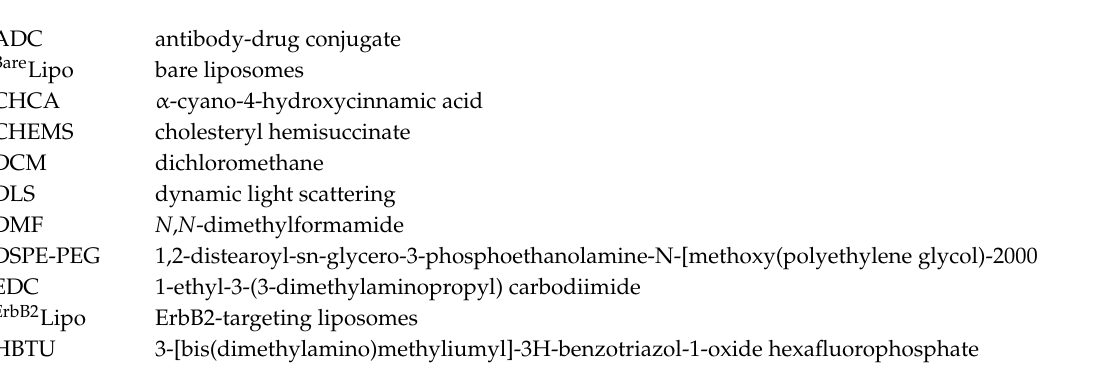
Table S1. Fmoc determination. Figure S1. Synthetic chemical structure of DSPE-PEG-ErbB2. Figure S2. Characterization of ErbB2 Lipo. (A) Size of ErbB2 Lipo under physiological condition (pH 7.4, 6.5 and 5.0, respectively) for 5 days. (B) PDI of ErbB2 Lipo under physiological condition (pH 7.4, 6.5 and 5.0, respectively) for 5 days. (C) Encapsulation e ffi ciency (red) and loading e ffi ciency (black) of rapamycin in the ErbB2 Lipo. (D) Cumulative release of rapamycin at 37 ◦ C in PBS pH 6.5 and pH 7.4. Figure S3. MDA-MB-231 and BT-474 cellular level of ErbB2 (185 kDa). GAPDH was used as an internal control (37 kDa). Figure S4. B. Representative images of